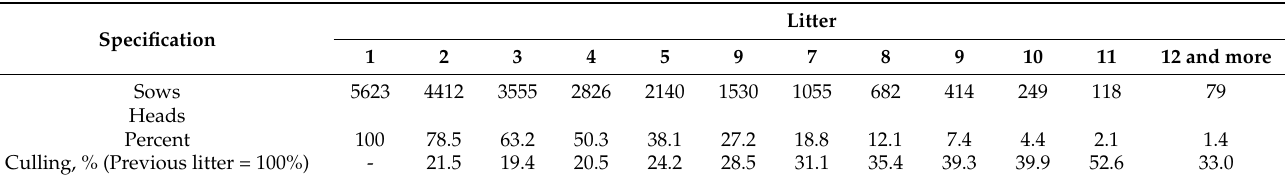
Table 1. Number and percentage of sows, which have given birth to further parity. Specification